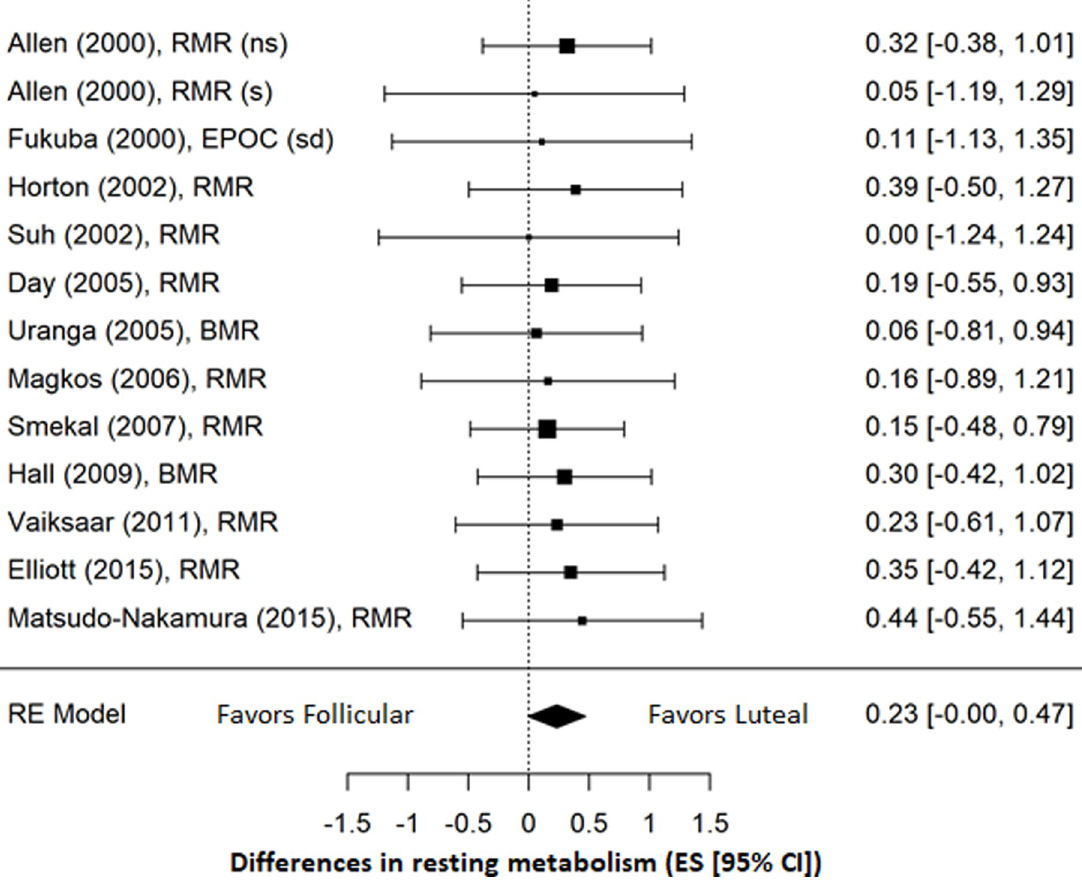
Fig 6. Forrest plot of sub-group analysis of studies published in 2000 and after. (ns) = non-smokers; (s) = smokers; (sd) = standard diet.